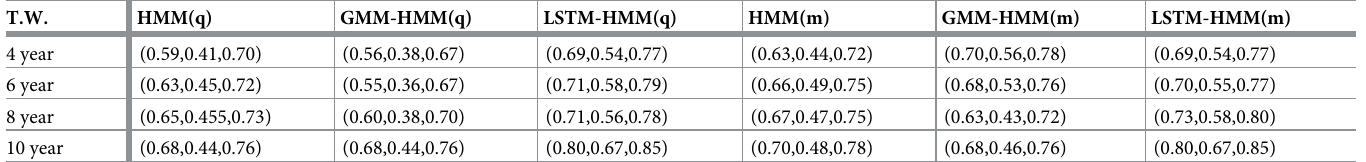
Table 15. Comparing HMM, GMM-HMM and LSTM-HMM with monthly or quarterly input and 4-year, 6-year, 8-year or10-year time windows based on Accuracy, Kappa and AUC.